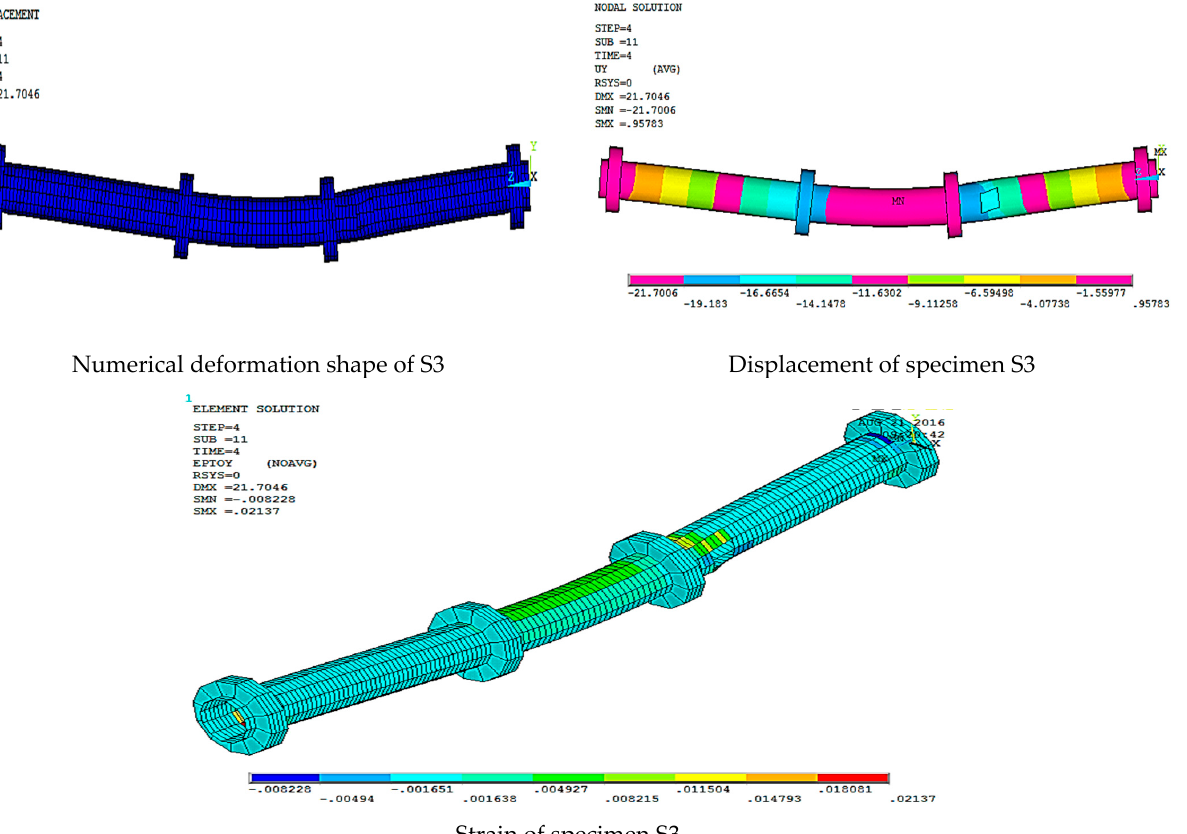
Figure 18. Numerical analysis of S3.